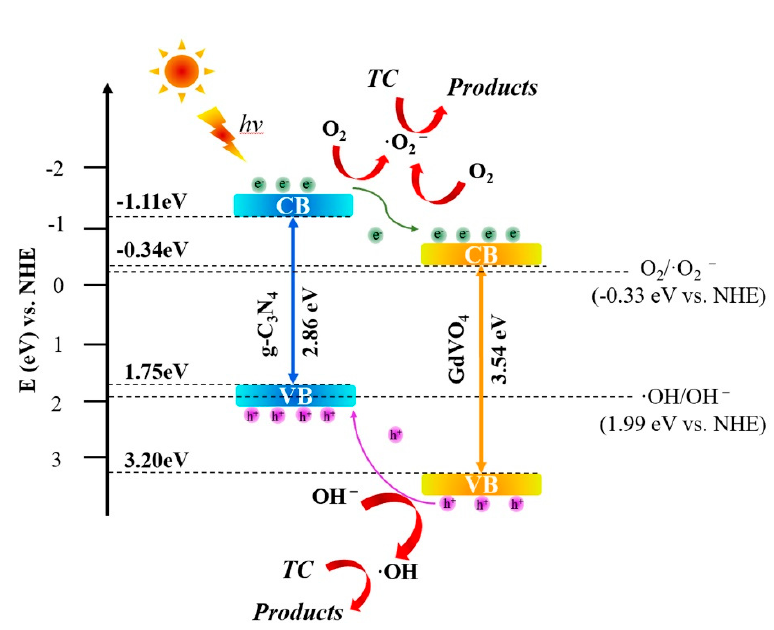
Figure 8. The possible degradation mechanism of GdVO 4 /g-C 3 N 4 composite.